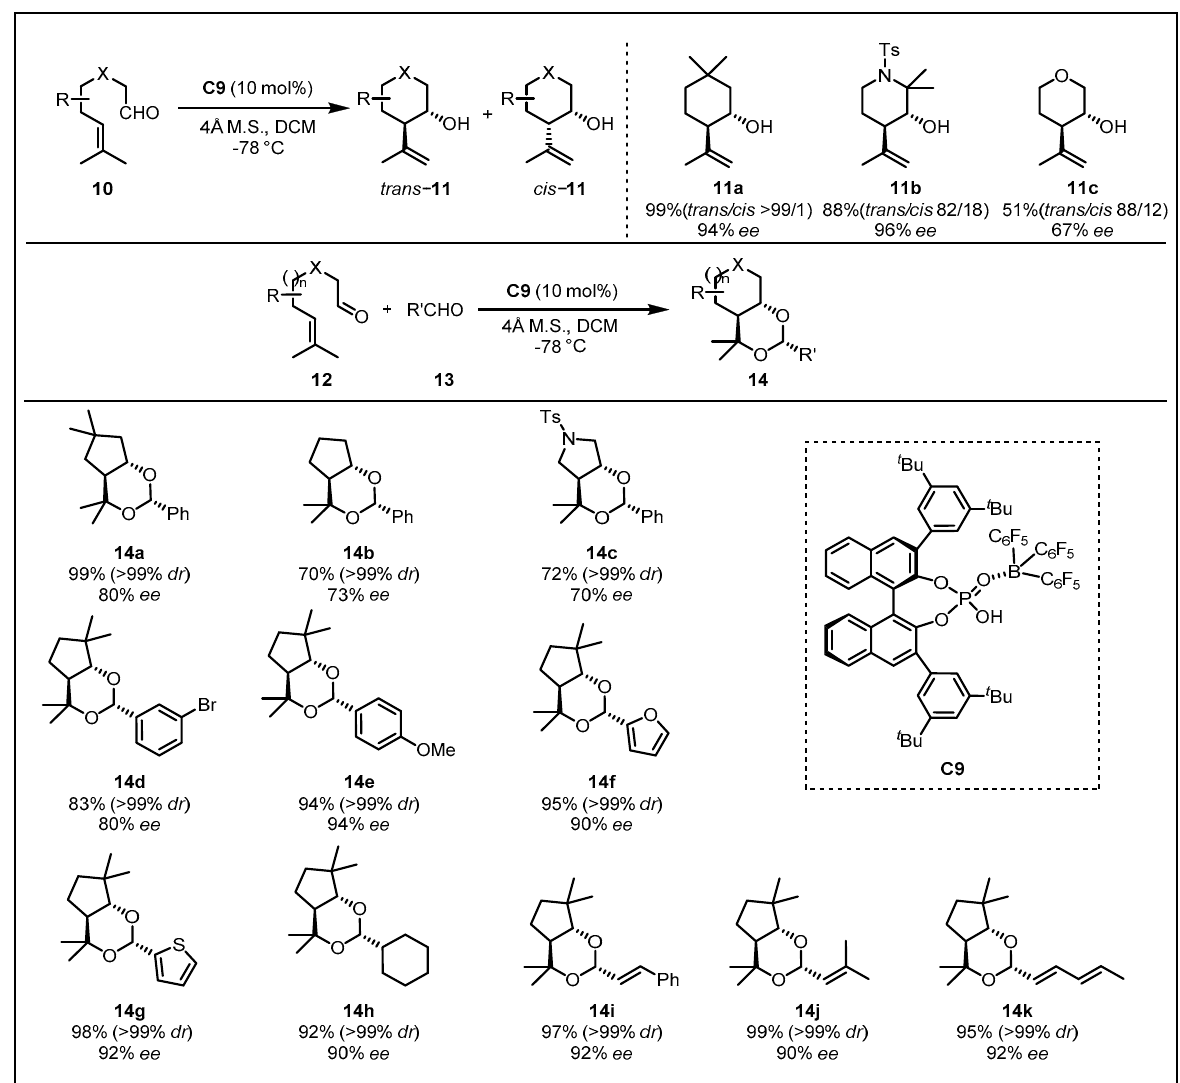
Figure 6. Carbonyl-ene cyclization and carbonyl-ene cyclization–acetalization tandem reactions catalyzed by C9 .